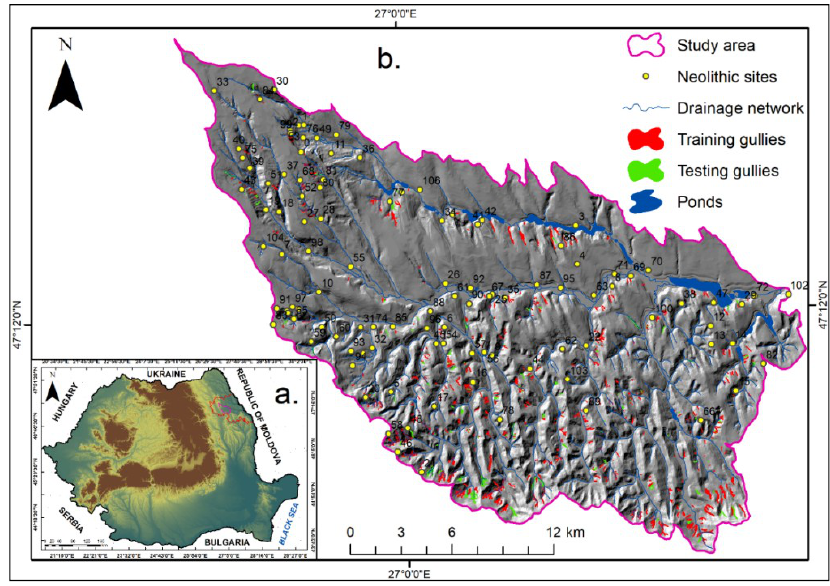
Figure 2. ( a ) Location of the study area in Romania; ( b ) Location of training and testing gully dataset and of Neolithic sites.